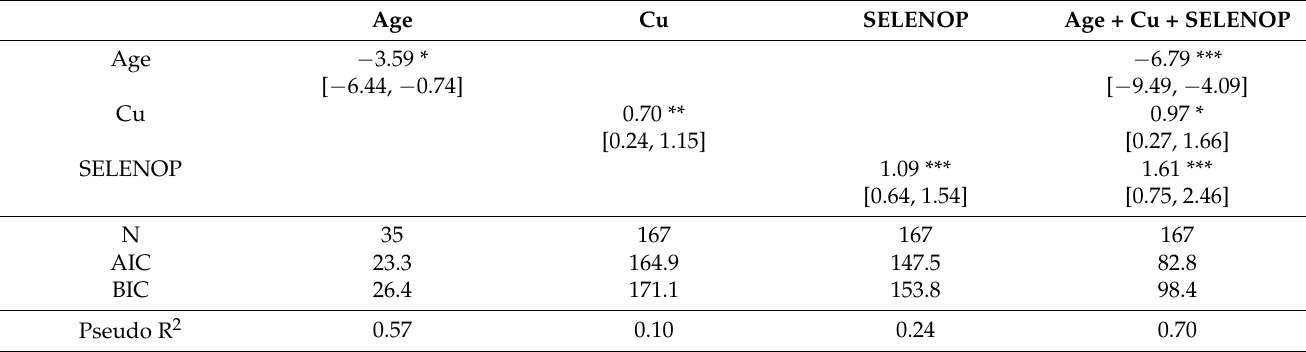
Figure 4. Receiver operating characteristics (ROC) analyses of Cu and Se status biomarkers in relation to survival or death from COVID-19. ( A ) Overview on ROC analyses as univariate prediction models for risk of death based on the serum concentrations of the biomarkers of Cu and Se status, i.e., based on serum Cu (green), CP (light green), Se (blue) and SELENOP (light blue) in isolation. ( B ) Overview on the predictive value of combined markers consisting of both Cu status biomarkers (Cu and CP, light violet) in comparison to mixed markers of Cu and Se status, i.e., Cu and Se (pale violet) and Cu and SELENOP (dark violet), respectively. ( C ) The final biomarker of serum Cu and SELENOP along with age outperformed the other combinations and correctly predicted non-survival with an area under the curve (AUC) of 95.0%. The relative performance is indicated in relation to a non-informative biomarker at the diagonal line at an AUC of 50%. This notion is further underlined by the specific characteristics of the models used (Table 2). Table 2. Specific characteristics of the predictive models used. For each model, the variable estimates included in the calculations are provided with their corresponding confidence interval (CI).